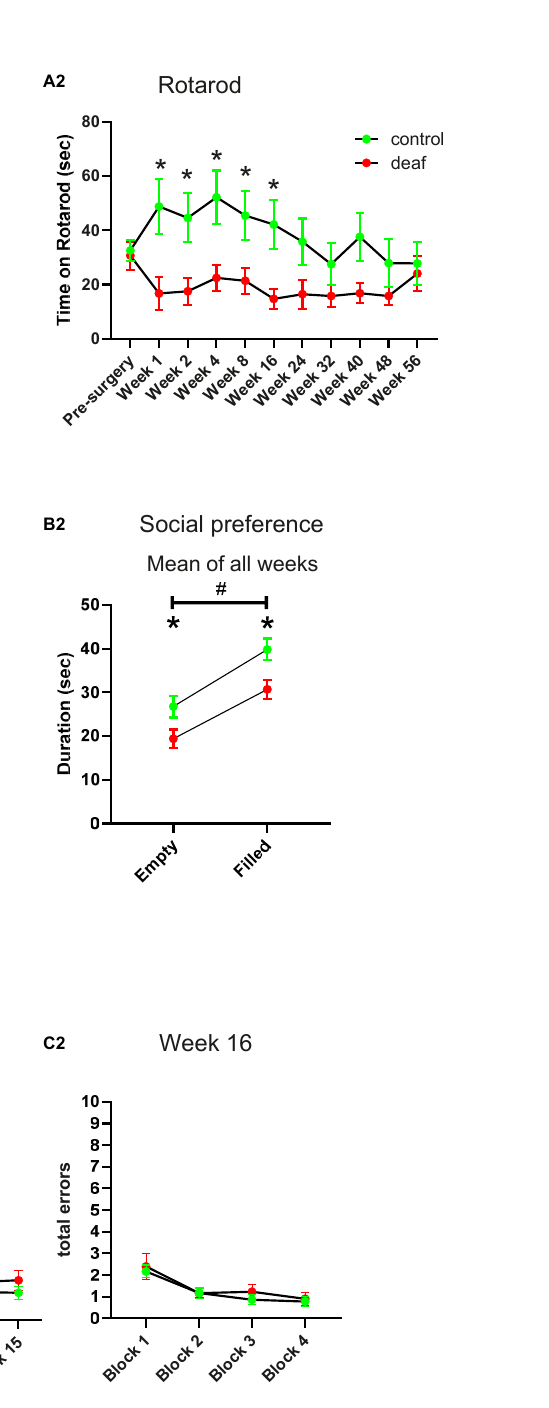
FIGURE2 Performance of rats during testing for motor impairment (A) , social behavior (B) , and cognitive behavior (C) with data shown as means ± SEM for deaf and sham or naïve controls. Distance in open field (A1) , time on Rotarod (A2) , and time of social interaction (B1) is shown for the weeks of testing indicated with respect to measures just before surgery. The total duration of interaction with the empty containment versus containment filled with a social partner for all weeks of testing in the social preference paradigm is shown in panel (B2) . Total errors of rats initially learning the 4-arm baited 8-arm maze at week 8 after surgery for the different test blocks (C1) and during re-testing 16 weeks after surgery (i.e., 8 weeks after initial learning this paradigm, C2 ). Differences between deaf rats and controls are shown as asterisks ( ∗ P < 0.05 after ANOVA); asterisk in brackets indicate significant intergroup-differences after trend for significance in ANOVA ( ∗ ). Differences between empty and filled containment are shown by hashtag ( # P < 0.05 after